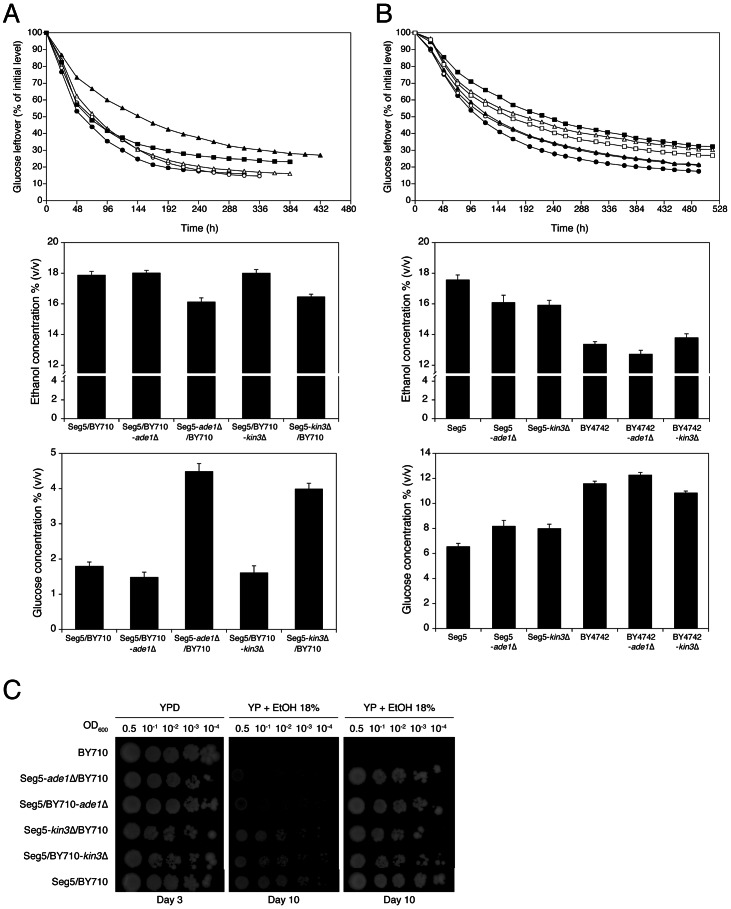
Single gene RHA and loss of function assessment for the causative genes ADE1 and KIN3 in QTL2.(A) RHA of genes ADE1 and KIN3. The diploid strain Seg5/BY710 (•) had ADE1 or KIN3 deleted in one of the alleles separately. The resulting strains Seg5/BY710-ade1Δ (○), Seg5-ade1Δ/BY710 (▴), Seg5/BY710-kin3Δ (Δ) and Seg5-kin3Δ/BY710 (▪) were compared with the original diploid Seg5/BY710 (•) in semi-static small-scale fermentations in YP+33% glucose at 25°C. The deletion of the alleles present in Seg5 resulted in diploids with lower ethanol accumulation capacity in comparison to the original strain and the deletion of the alleles from BY710. (B) ADE1 and KIN3 loss-of-function assays. The genes ADE1 and KIN3 were deleted in the haploid strains Seg5 (•) and BY4742 (Δ) separately. The strains Seg5-ade1Δ (○), Seg5-kin3Δ (▴), BY4742-ade1Δ (▪) and BY4742-kin3Δ (□) were evaluated by semi-static fermentations in 250 mL of YP+33% glucose at 25°C. (C) Determination of ethanol tolerance of cell proliferation with the hybrid diploid strains Seg5/BY710-ade1Δ, Seg5-ade1Δ/BY710, Seg5/BY710-kin3Δ and Seg5-kin3Δ/BY710.